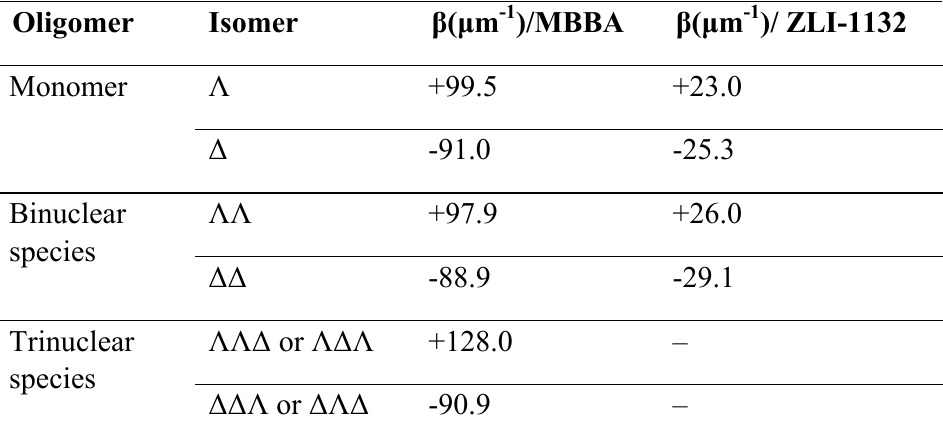
Table 4. The spectroscopic properties of [Cr(acac) MBBA and ZLI-1132 at 30 °C. Table modified from reference